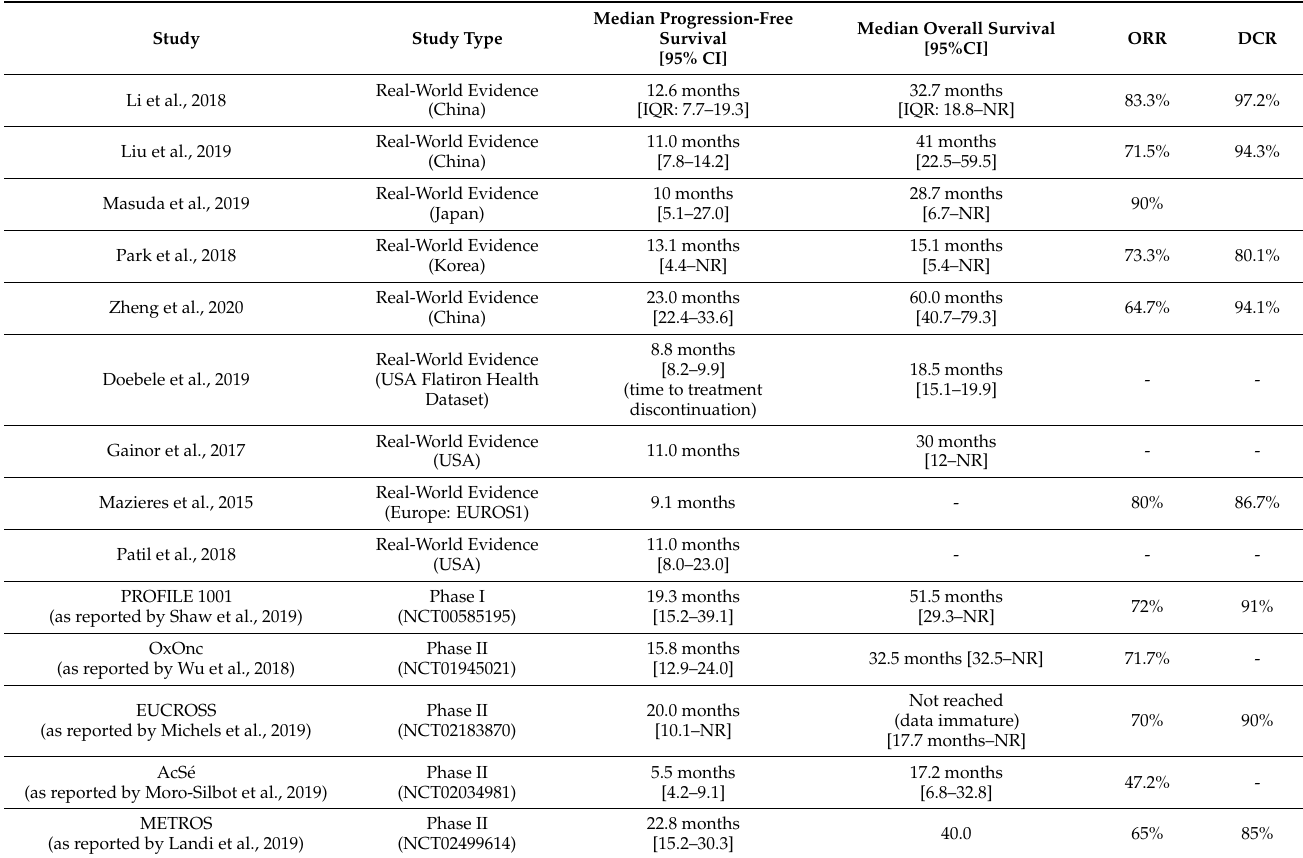
Table A1. Overview of outcomes for clinical trial and real-world studies with crizotinib-treated